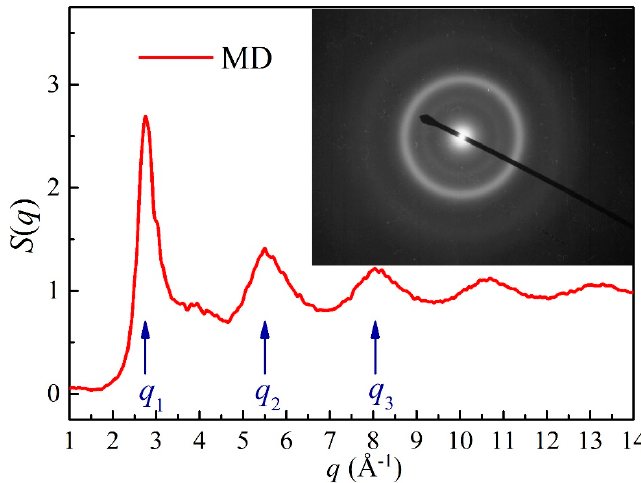
Figure 5. The structure factor S ( q ) of the Ni 52 Nb 35 Mo 13 alloy derived from MD simulation [55] and the corresponding selected area diffraction (SAD) patterns [71]. The q 1 , q 2 and q 3 represent the first, second and third peak positions of the structure factor S ( q ).